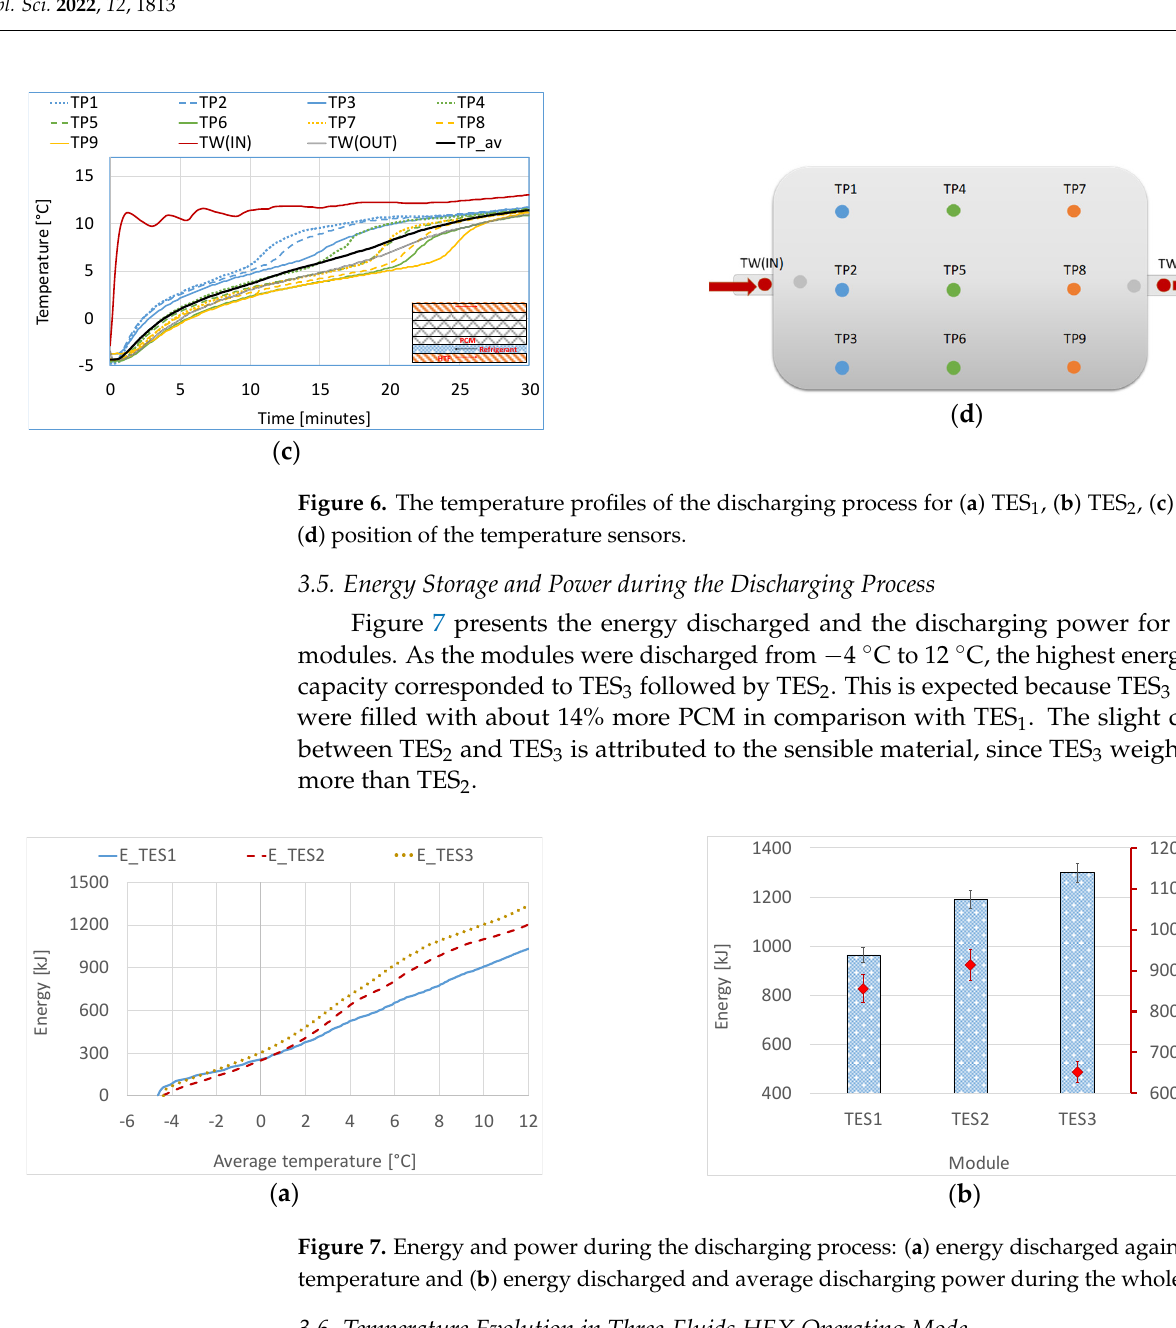
temperature and ( b ) energy discharged and average discharging power during the whole process.